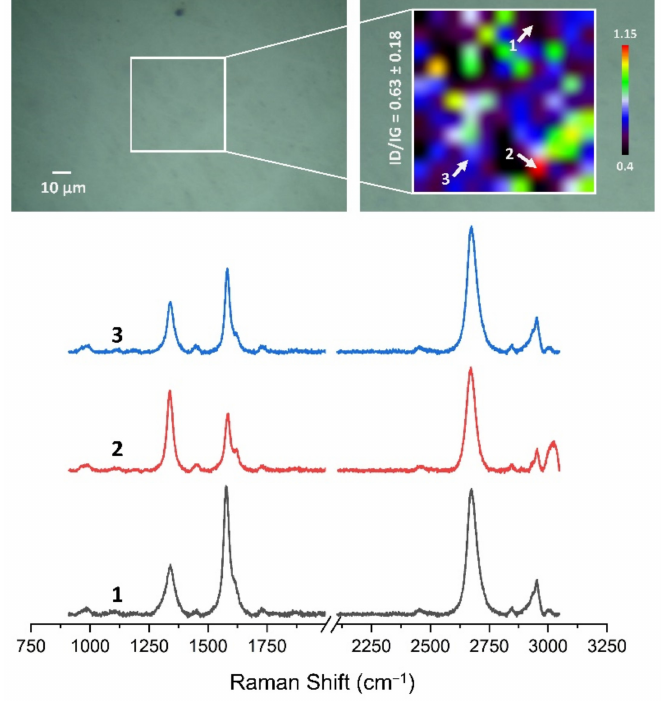
Figure 14. The Raman map and spectra of HSMG ® graphene transferred onto Al 2 O 3 ceramic substrates modified by RF PACVD oxygen